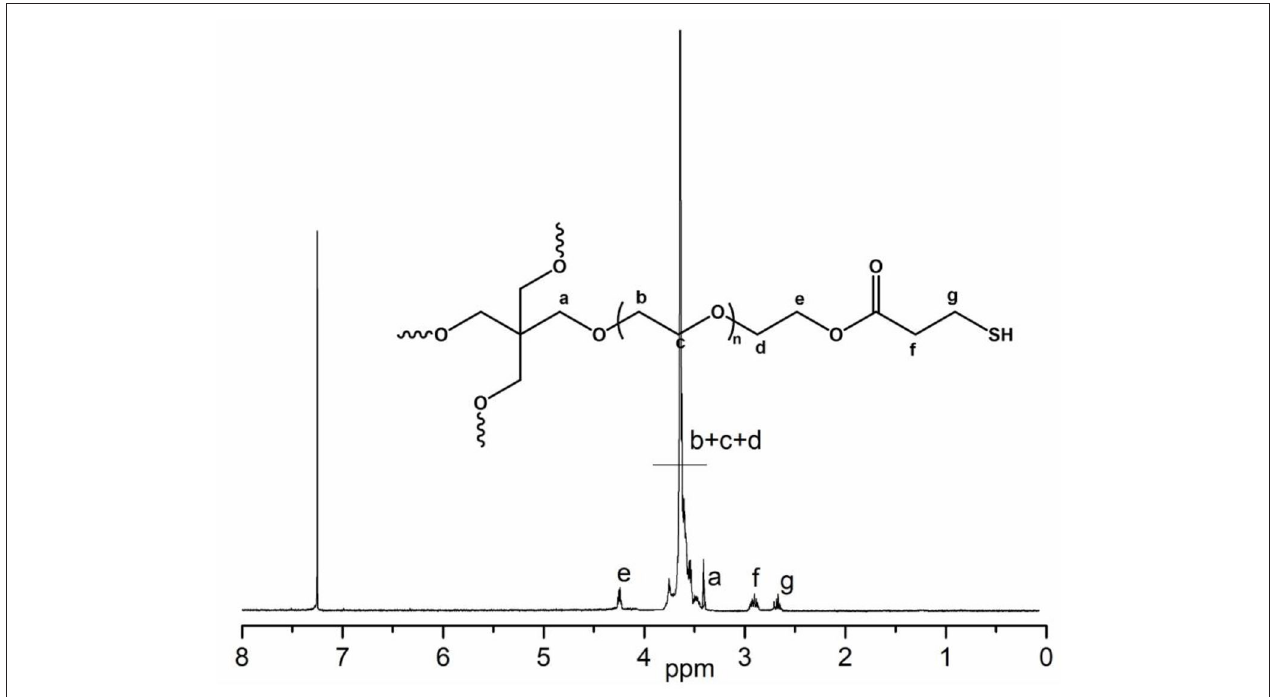
FIGURE 7 | 1 H NMR of 4-arm PEG-SH in CDCl 3 .